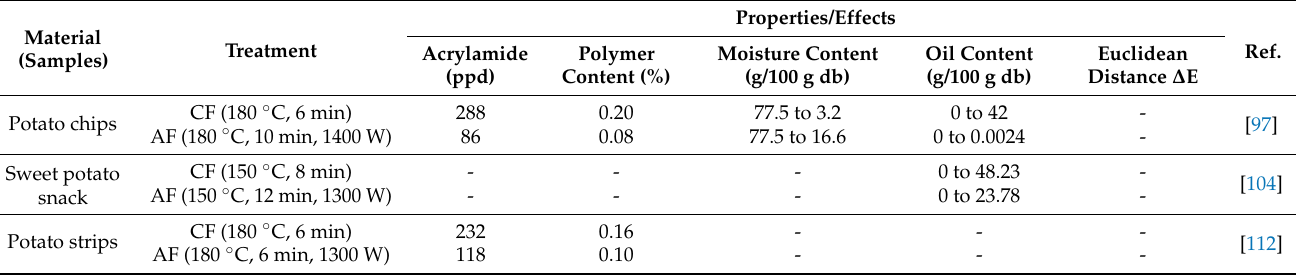
Table 5. Effects of air frying on different